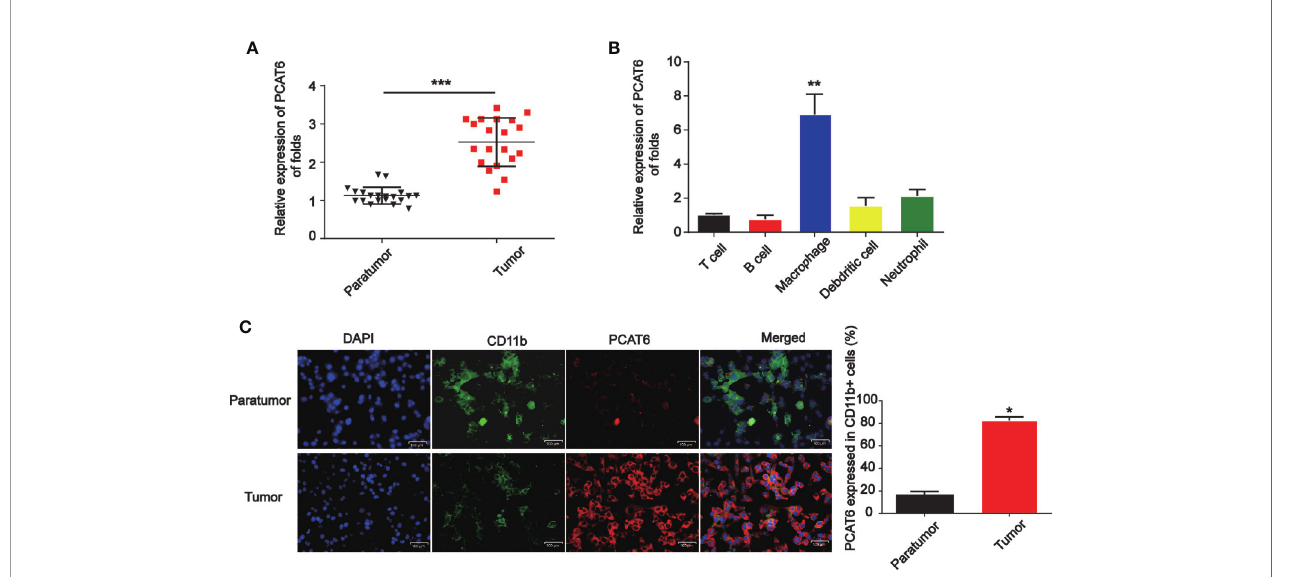
FIGURE 1 | PCAT6 was elevated in cholangiocarcinoma (CCA) patients. (A) mRNA expression of PCAT6 in the tumor tissues of CCA patients (n=20) and the healthy tissues (n=20) were compared. (B) The expression of PCAT6 in patient-derived immune cells was assessed using qRT-PCR analysis. (C) The tissue sections of the paratumors and tumors from CCA patients were analyzed by IFSH. Scale bar, 100 m m. *P < 0.05; **P < 0.01; ***P < 0.001. Compared with the control